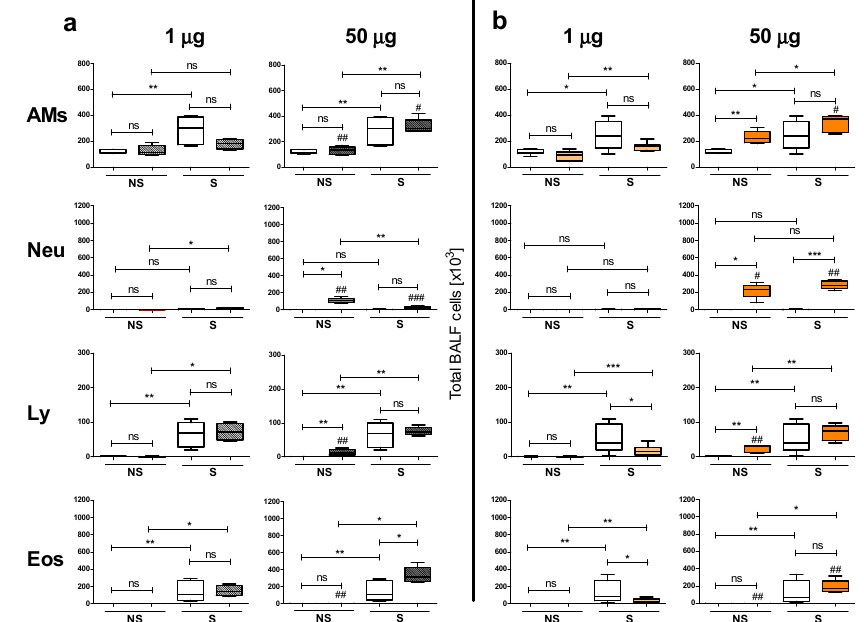
Figure 4. Ag-NPs size and surface modification significantly affects their in vivo response. BALF cell analysis following intratracheal (i.t.) instillation of ( a ) Ag200-PVP and ( b ) Ag50-citrate prior to OVA challenge. In each graph, on the left are non-sensitized mice (NS) and on the right sensitized (S) mice. White plots represent particle-free supernatant (SUP) controls and filled/colored plots depict NP-treated lungs. The dose is given above. AMs, alveolar macrophages; Neu, neutrophils; Ly, lymphocytes and Eos, eosinophils. ( n = 5–10/group) * p < 0.05, ** p < 0.01; ns, not significant; # p < 0.05, ## p < 0.01, ### p < 0.001 vs. respective groups treated with Ag50-PVP.